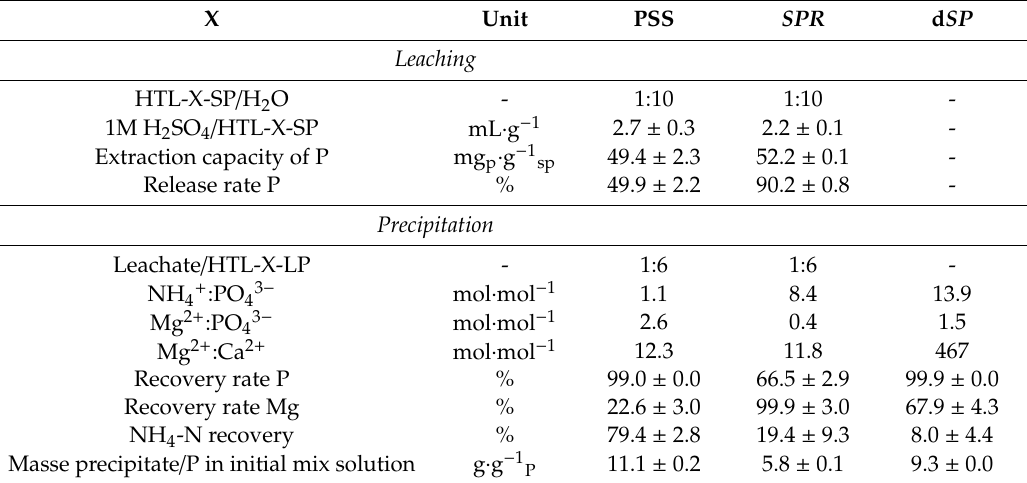
Table 3. Performances of phosphate